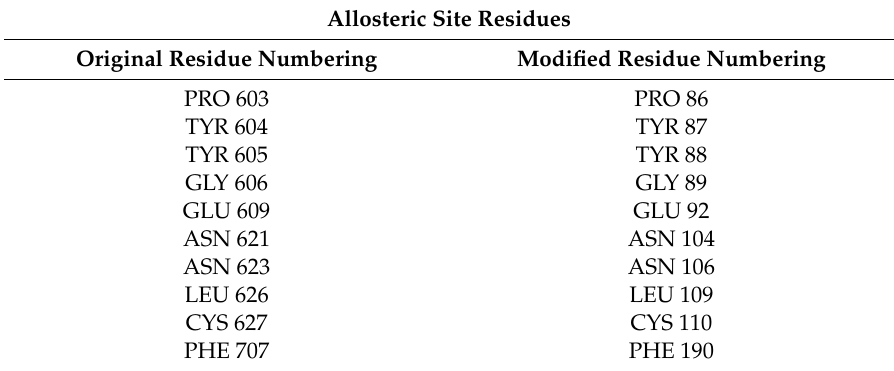
Table 1. Original numbering of allosteric residues of the Nedd4-1 obtained from the original crystal structure with the corresponding residue numbering after running